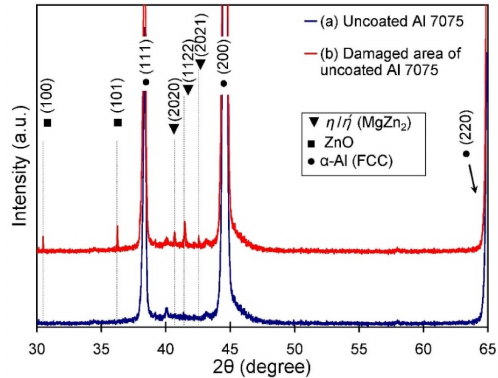
Figure 3. X-ray diffraction patterns of: ( a ) uncoated Al 7075-T6; and ( b ) damaged area of uncoated Al